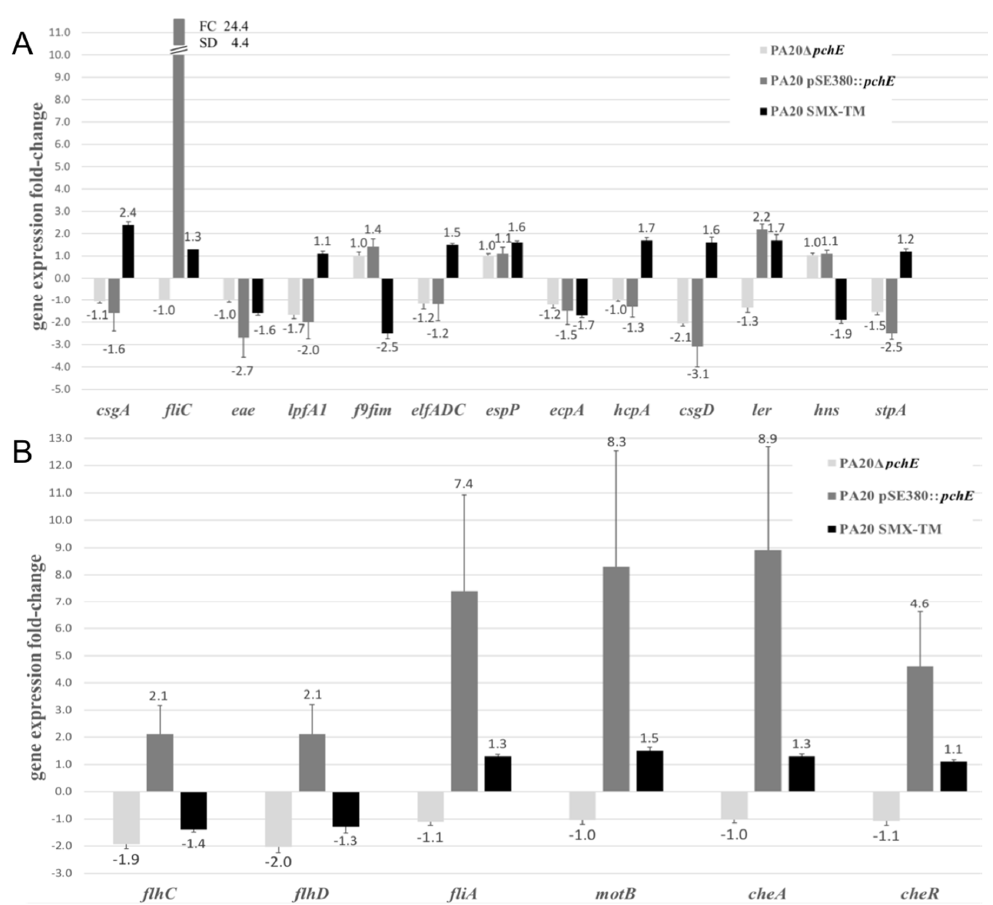
Figure 1. qRT-PCR-derived fold-change (FC) expression differences. Expression differences for the indicated genes derived from the comparison of strain PA20 with: 1) PA20 ∆ pchE , 2) PA20 pSE380:: pchE , and 3) PA20 SMX-TM (PA20 exposed to 540/108 μg/L sulfamethoxazole/trimethoprim (SMX-TM)). ( A ) Genes of proven adhesins and global adhesin regulators. ( B ) Flagellar motility-associated genes. The mean FC ± SD of three trials of qRT-PCR for each indicated gene is shown.